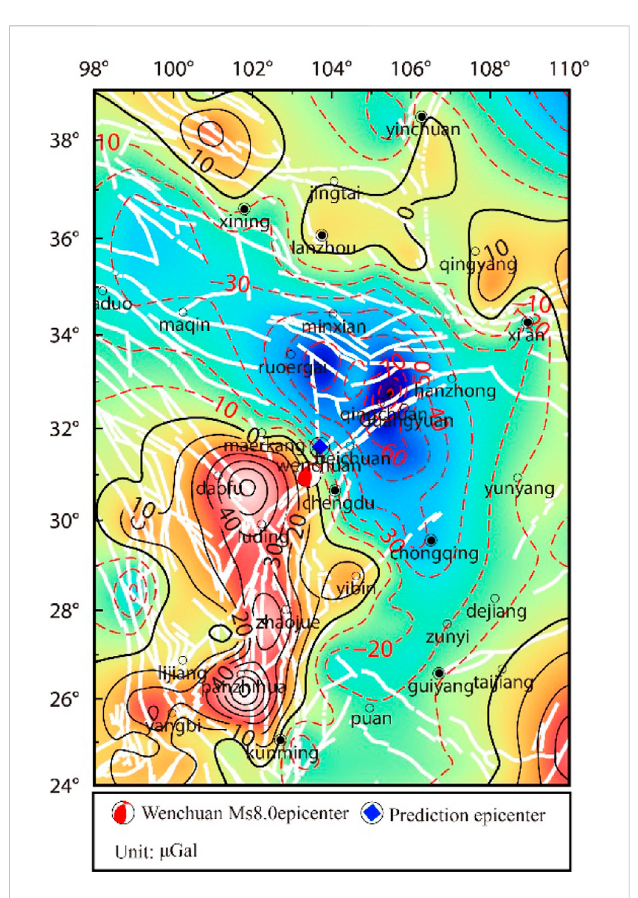
FIGURE 2 Gravity changes before the Wenchuan Ms 8.0